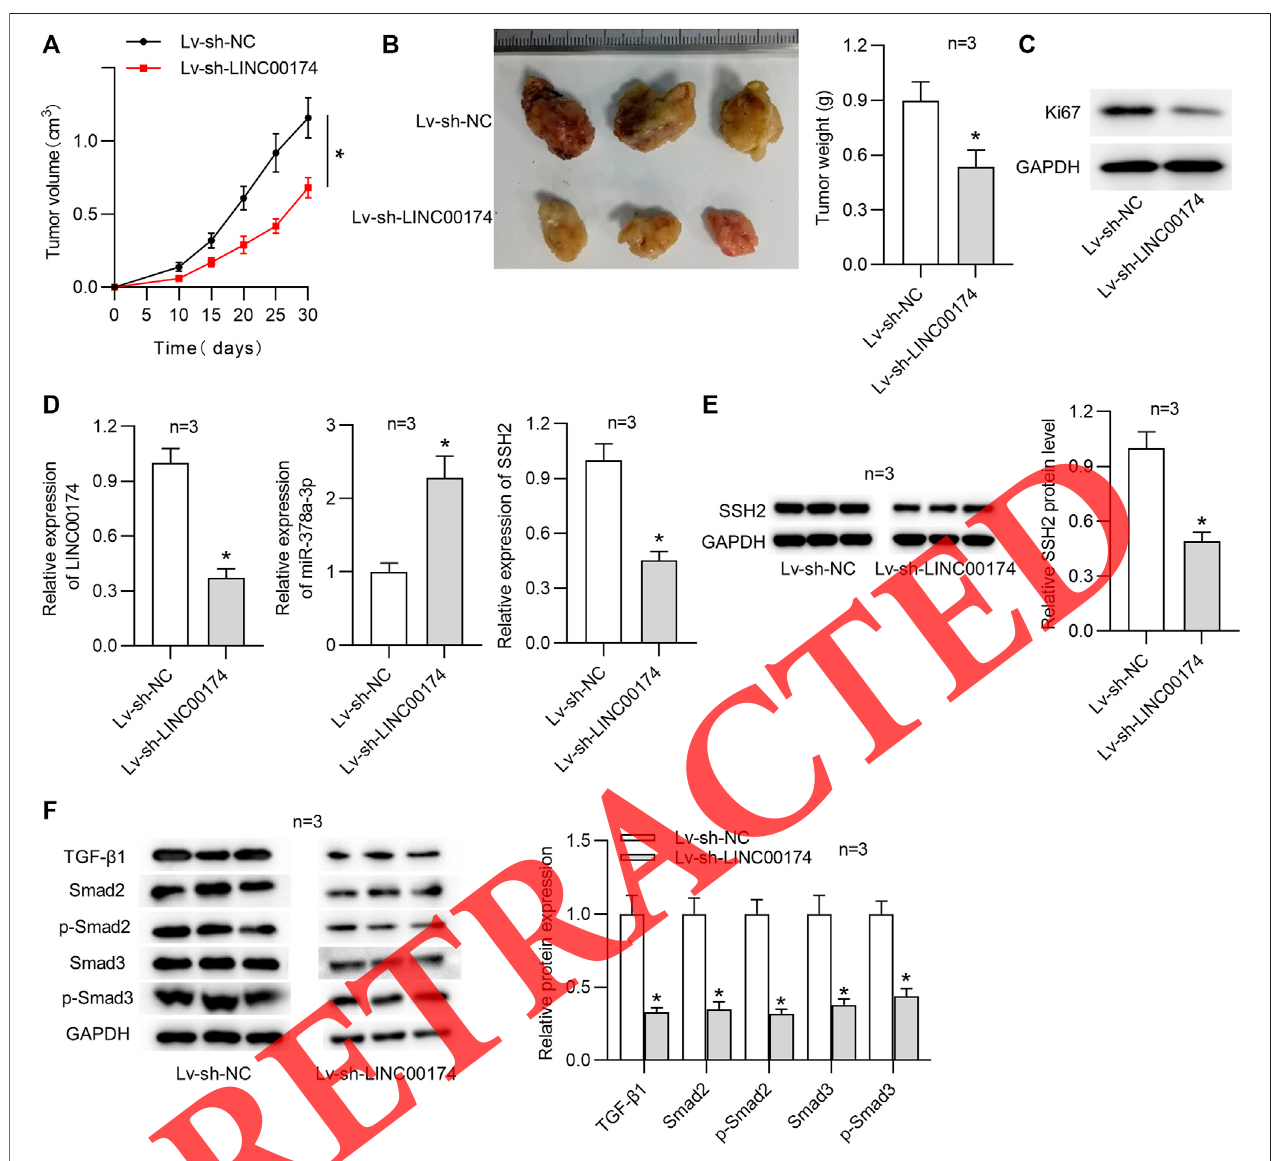
FIGURE8| LINC00174promotesOSprogression invivo . (A) ThetumorvolumewasrecordedunderLINC00174knockdown. n (cid:2) 3.Signi fi cancewasanalyzedby Student ’ s t-test. (B) Tumor images and tumor weight under LINC00174 silencing. n (cid:2) 3. Signi fi cance was analyzed by Student ’ s t-test. (C) The expression of Ki67 in xenograft tumor tissues in each group was determined by western blot. n (cid:2) 3. (D) Expression levels of LINC00174, miR-378a-3p and SSH2 in xenograft tumor tissues were examined by RT-qPCR. n (cid:2) 3. Signi fi cance was analyzed by Student ’ s t-test. (E) SSH2 protein level in xenograft tumor tissues under LINC00174 de fi ciency was measured by western blot. n (cid:2) 3. Signi fi cance was analyzed by Student ’ s t-test. (F) TGF- β 1, SMAD2, SMAD2 (phospho S255), SMAD3, and SMAD3 (phospho T179) protein levels in xenograft tumor tissues under LINC00174 de fi ciency was measured by western blot. n (cid:2) 3. Signi fi cance was analyzed by Student ’ s t-test. * p <